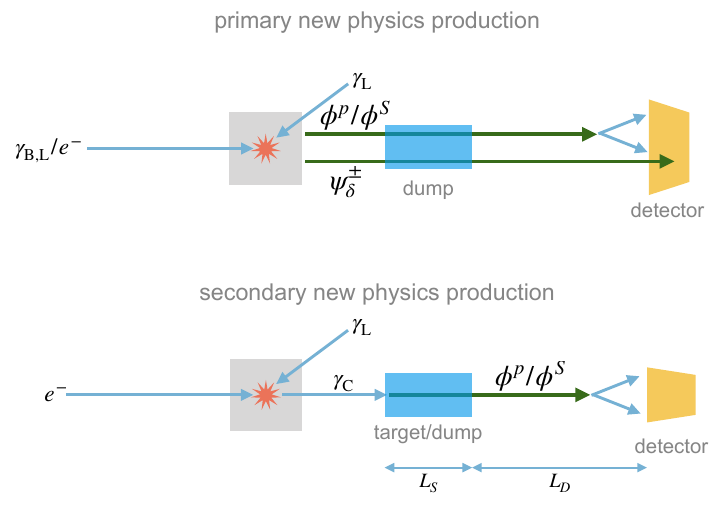
Figure 3: Possible production modes of long-lived BSM particles in LUXE [ 8 ]